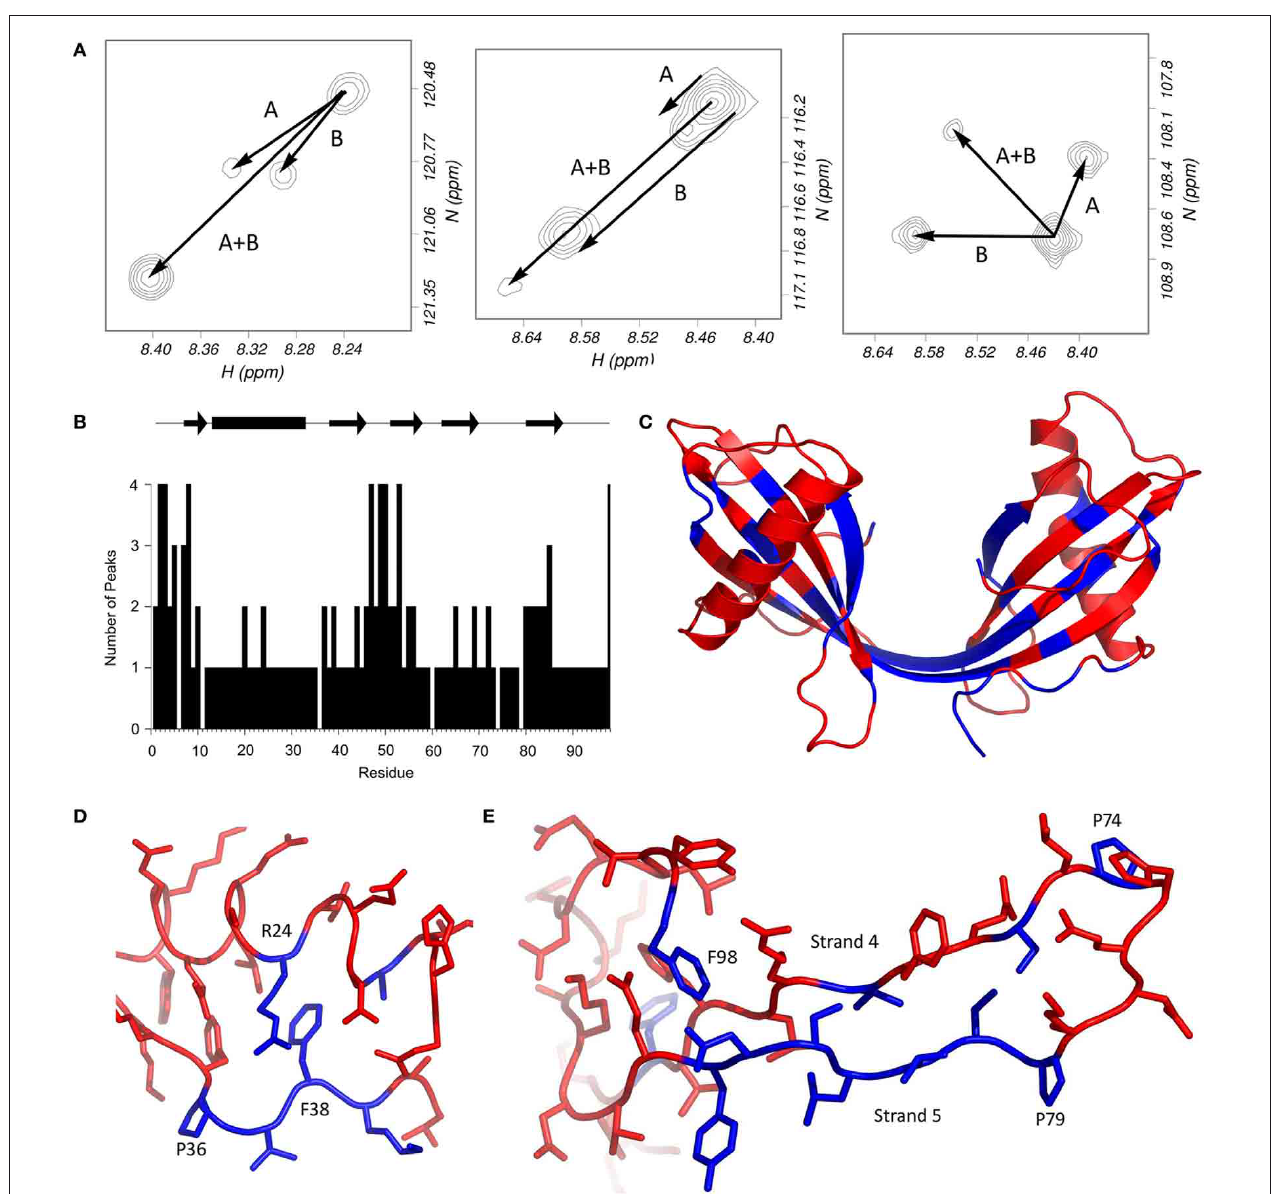
FIGURE 2 | Multiple HSQC peaks in the spectrum of the stefin B dimer. (A) Pattern of multiple peaks in the HSQC spectrum. To illustrate, the four peaks assigned to each of methionine 2 (left), serine 7 (centre) and glycine 50 (right) suggest that two conformational changes (labeled A and B) can account for the four states. (B) The number of peaks in the HSQC are plotted against residue number. (C) Residues with multiple peaks are colored blue in the structure of the dimer (bottom). (D) Multiple HSQC peaks around proline 36. In this view of the stefin B monomer (PDB code 1STF), residues with multiple peaks (and proline 36) are blue; other peaks are red. Proline 36 is in the trans conformation, and isomerization could